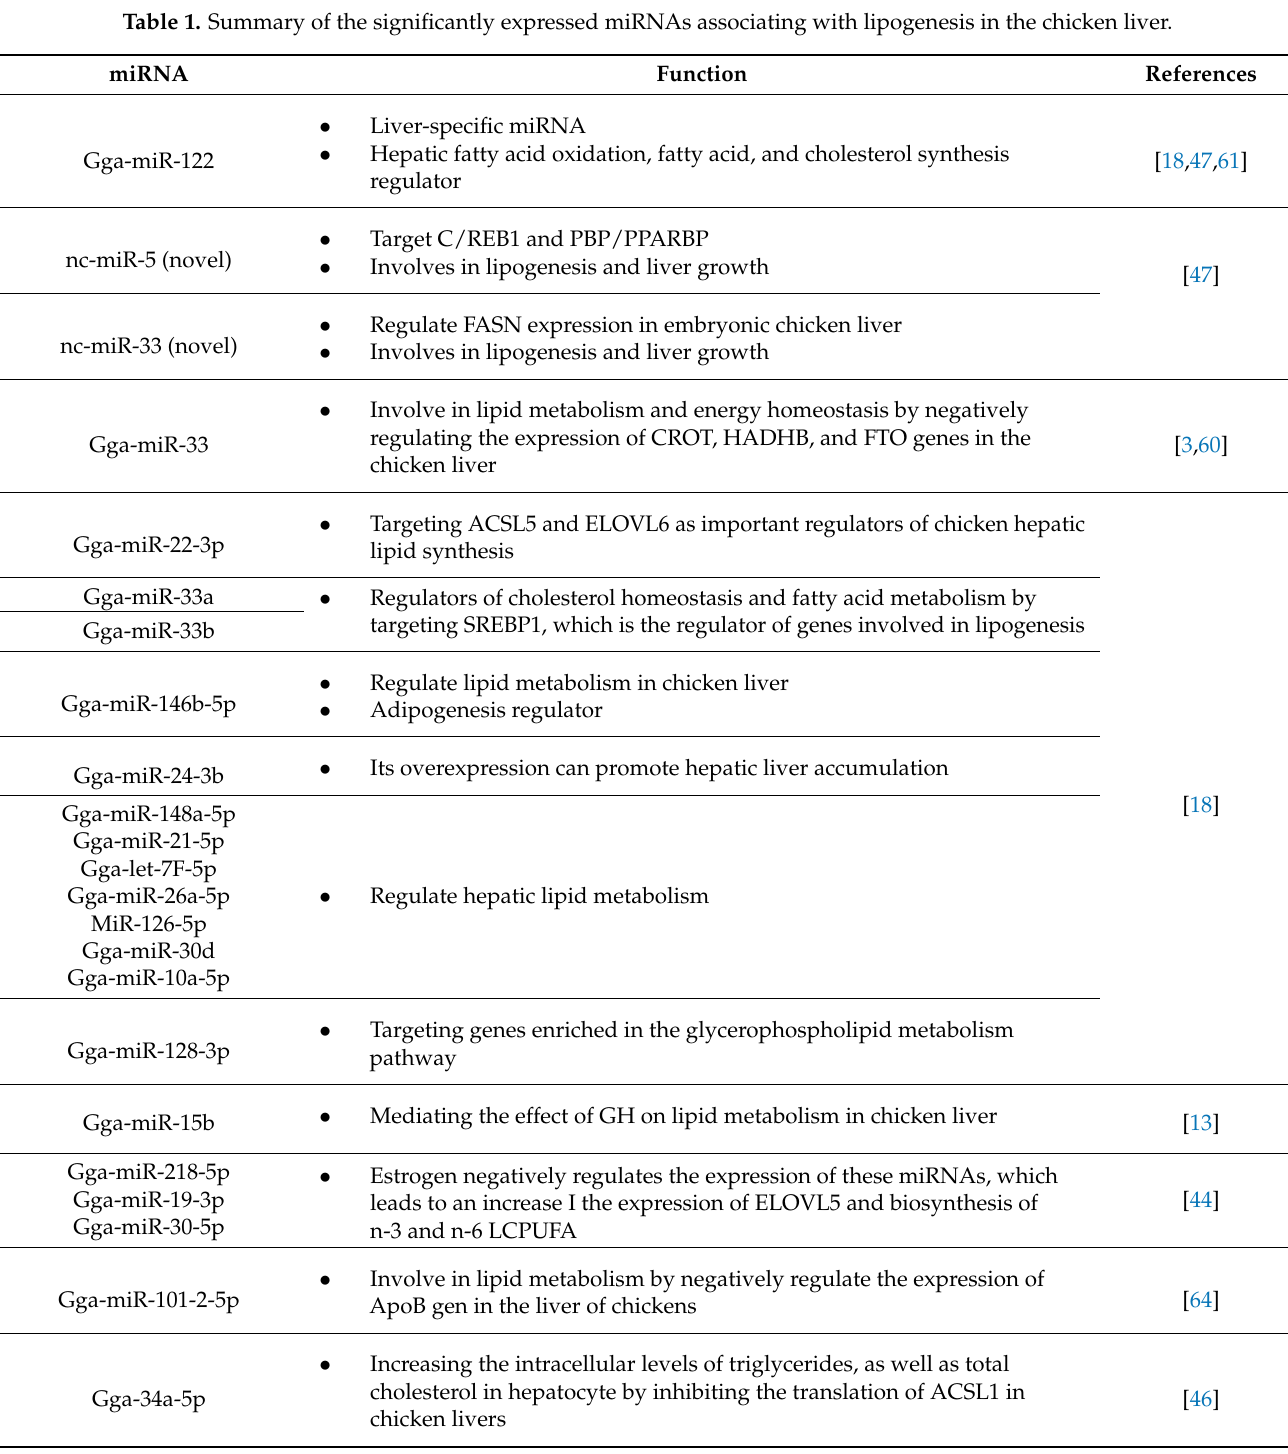
Table 1. Summary of the significantly expressed miRNAs associating with lipogenesis in the chicken liver. miRNA